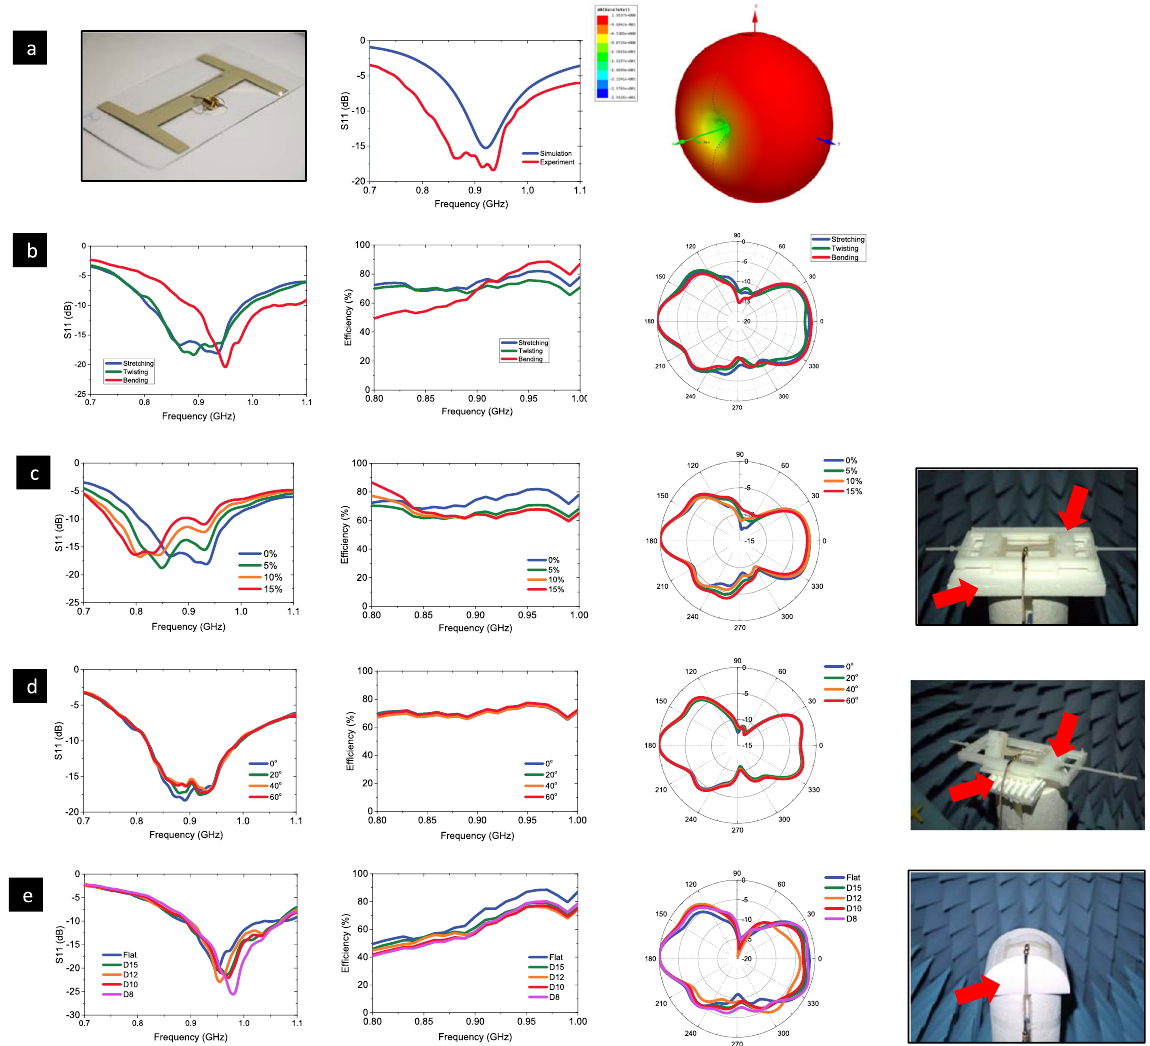
Figure 5. Stretched, Twisted and Bent antenna using 22 v% Ag-PDMS and their transmission performances. ( a ) The outlook of the off-body dipole antenna, the return losses of the unstretched off-body antenna from experiment and simulation, and the 3D radiation pattern of the unstretched off-body antenna, respectively; ( b ) the antenna performance in the initial conditions: 0% stretch, 0-deg twist, and no bending; ( c ) the antenna under stretching; ( d ) the antenna under twisting; and ( e ) the antenna under bending. From left to right in ( b – e ) series, are the return loss, radiation efficiency, radiation pattern in the cut-plane pi = 0°, and view of the testing environment,